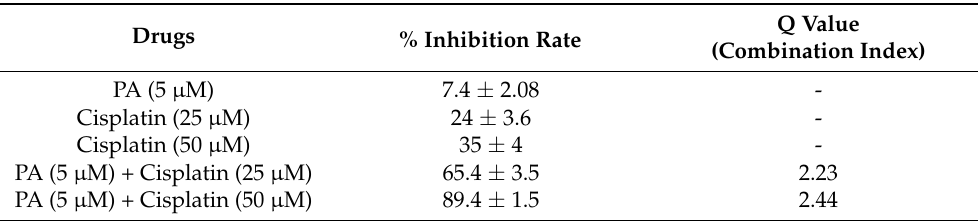
Table 1. Combination index of planispine A and cisplatin using Jin’s formula. The data are expressed as the mean ± S.D. in triplicate. ( p <